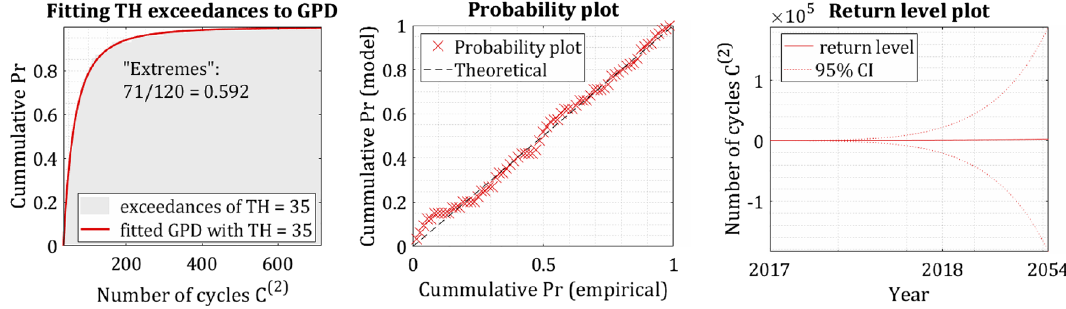
Fig. 11 Example of POT results for the range dS 2 : (i) fitting GPD to histogram of C ( 2 ) , (ii) probability plot, (iii) return level